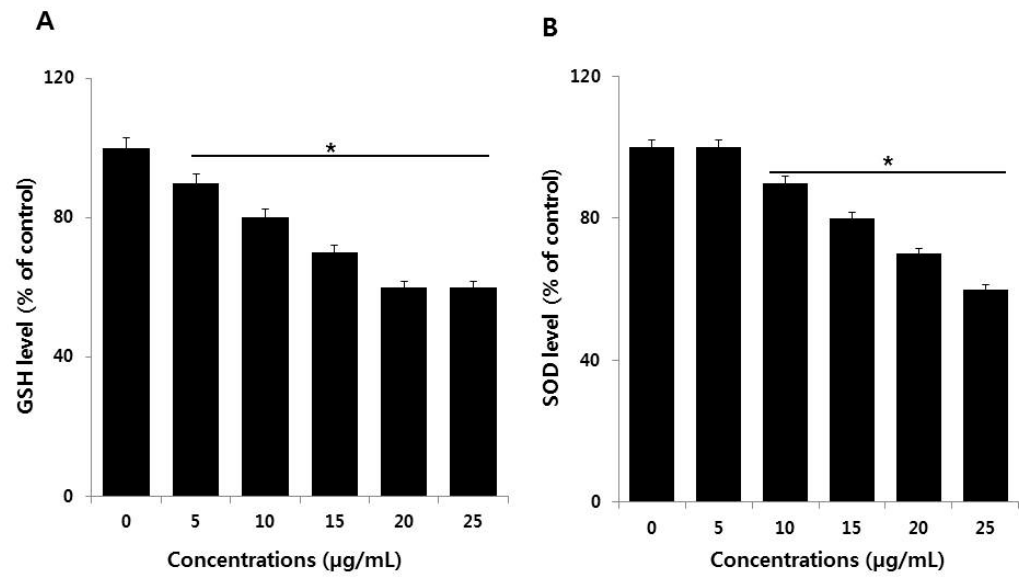
Figure 8. Measurement of antioxidants in NIH3T3 cells. Cells were treated with various concentrations of AgNPs for 24 h. After incubation, the cells were harvested, washed twice with ice-cold PBS, and disrupted by ultrasonication for 5 min on ice. ( A ) The concentration of glutathione (GSH) was expressed as milligram per gram of protein. ( B ) The specific activity of superoxide dismutase (SOD) was expressed as unit per milligram of protein. The results are expressed as mean ± standard deviation of three independent experiments. There was a significant difference in the ratio of AgNP-treated cells compared to untreated cells according to a Student’s t -test (* p < 0.05).